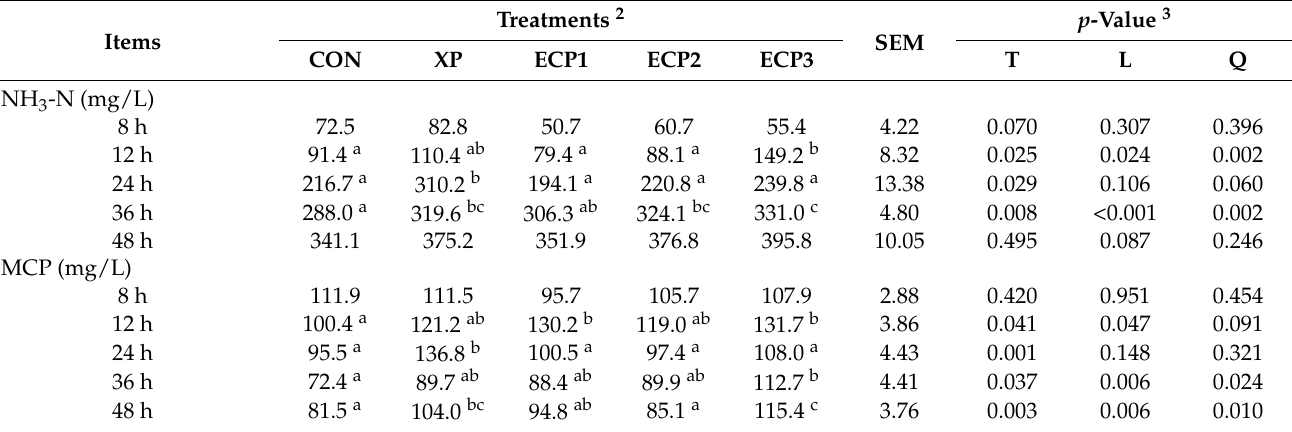
Table 3. Concentrations of NH 3 -N and MCP under different levels of ECP supplementation 1 .